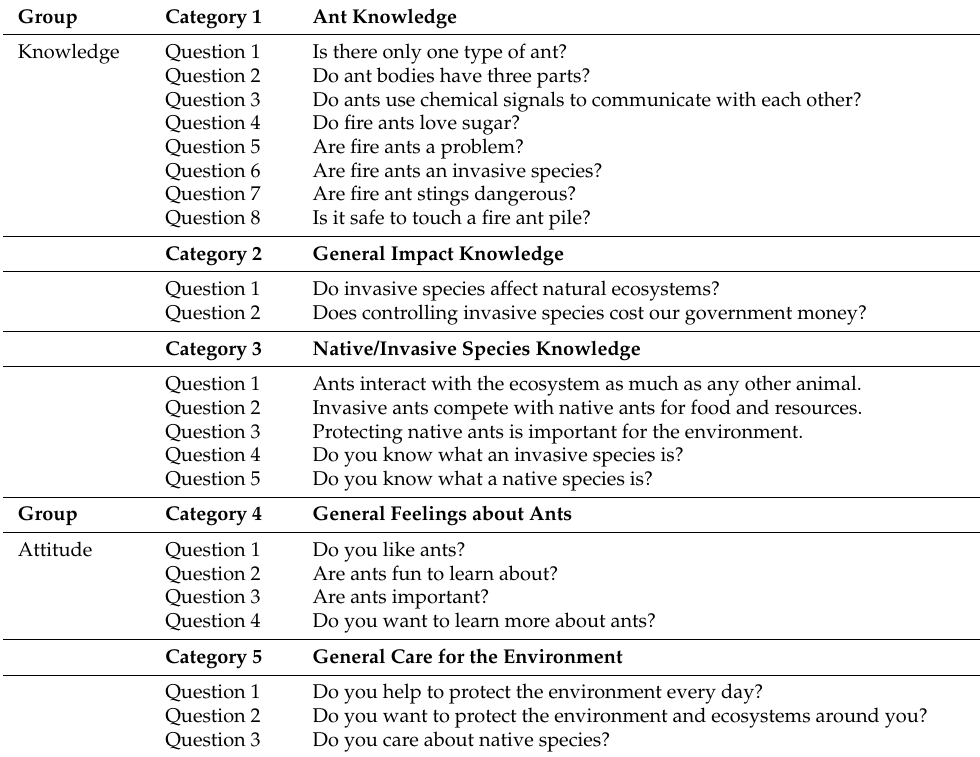
Table 1. Analysis design with questions organized into five categories distributed in two groups: Knowledge and